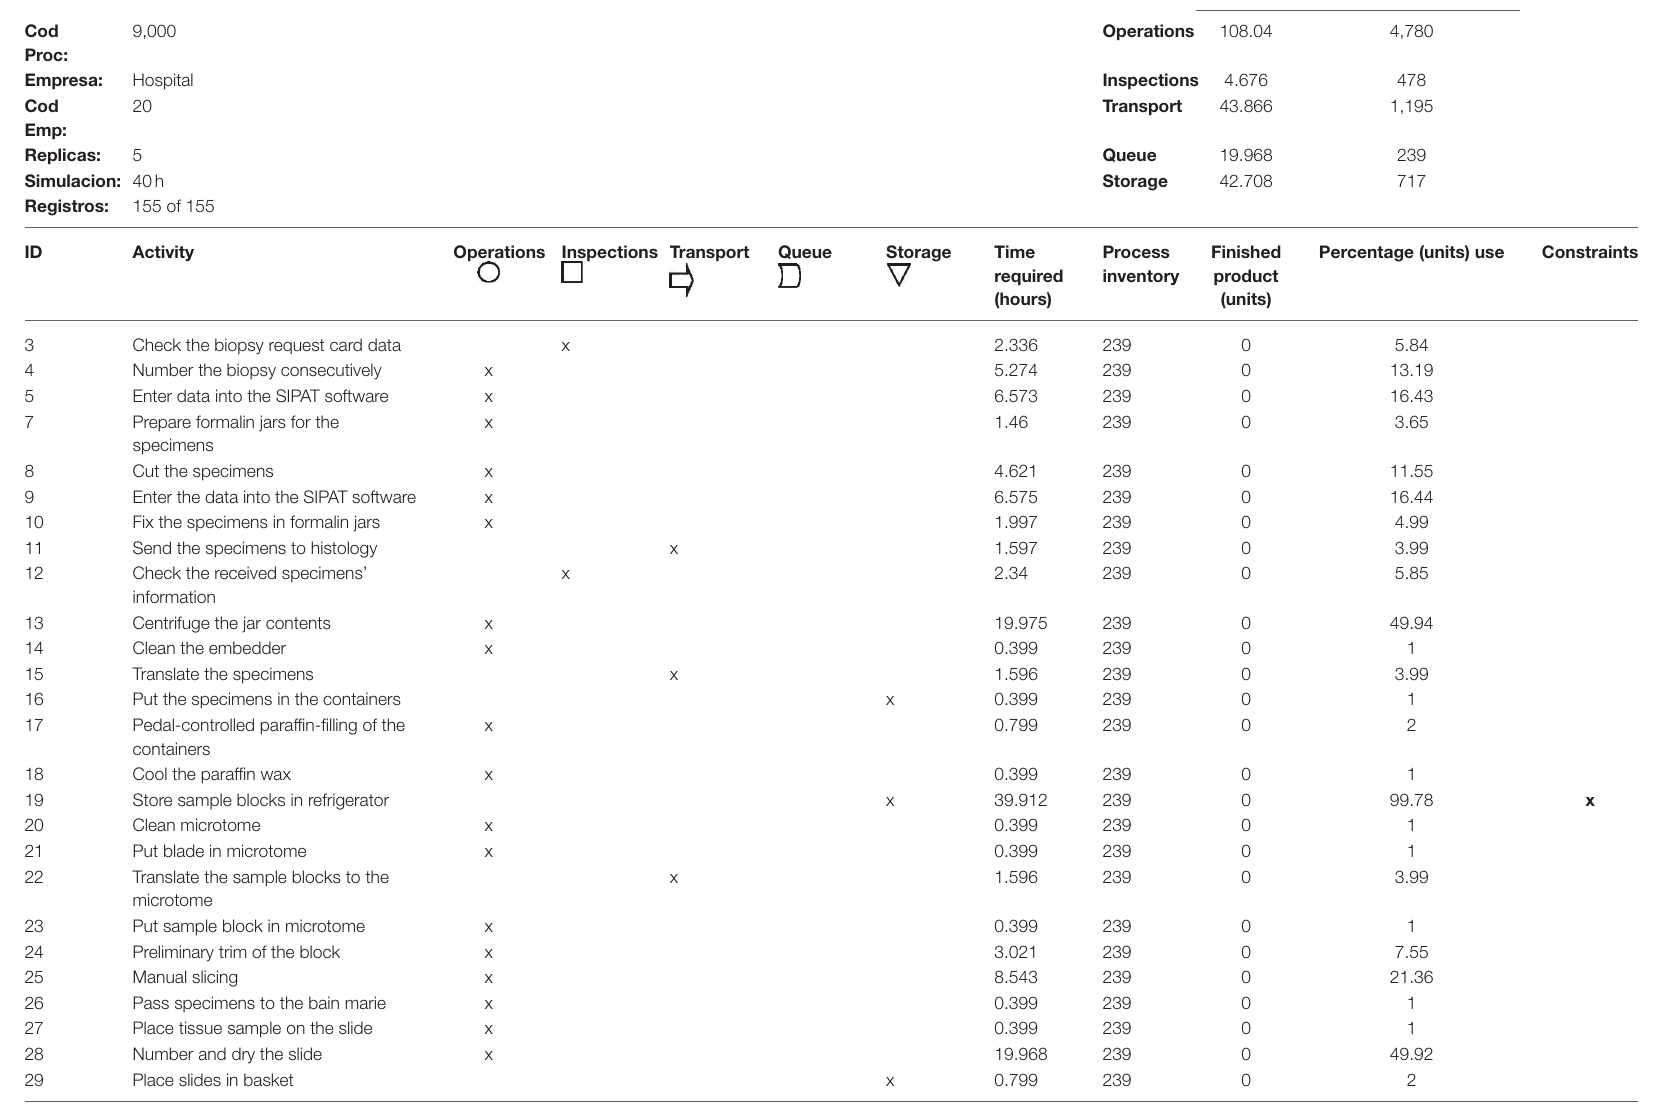
TABLE 7 | Forty-hour simulation of the pathology department’s biopsy process. Proceso: Biopsy processing (Group 1) Hours Process inv. (units)